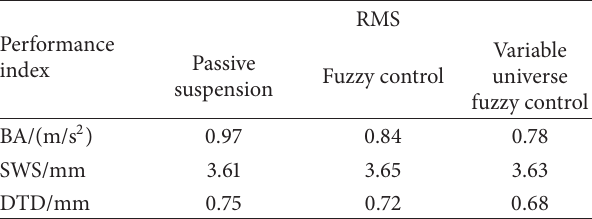
Table 4: Suspension performance of C-class random